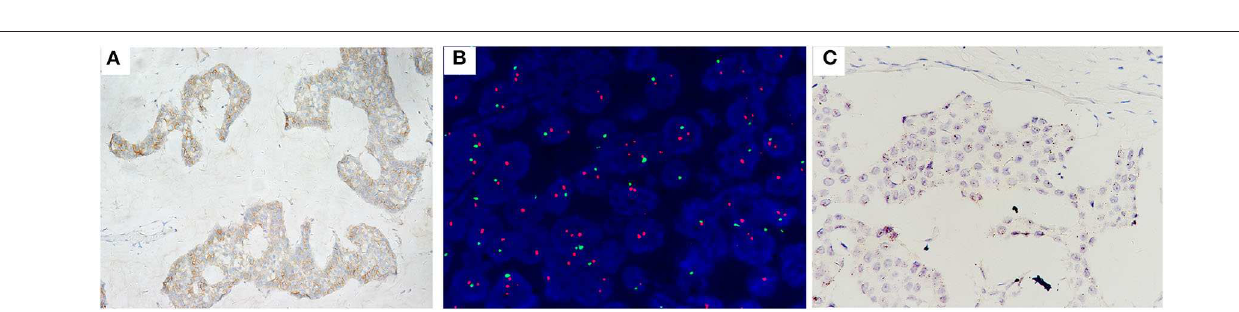
FIGURE 5 | Case no. 8 with, IHC2 + (A) , the lowest HER2/CEP17 ratio of 2.00, and the lowest average HER2 signals/cell of 2.10 (B) . Showed the lowest level of HER2 mRNA expression (score 1 by RNAscope) (C) .